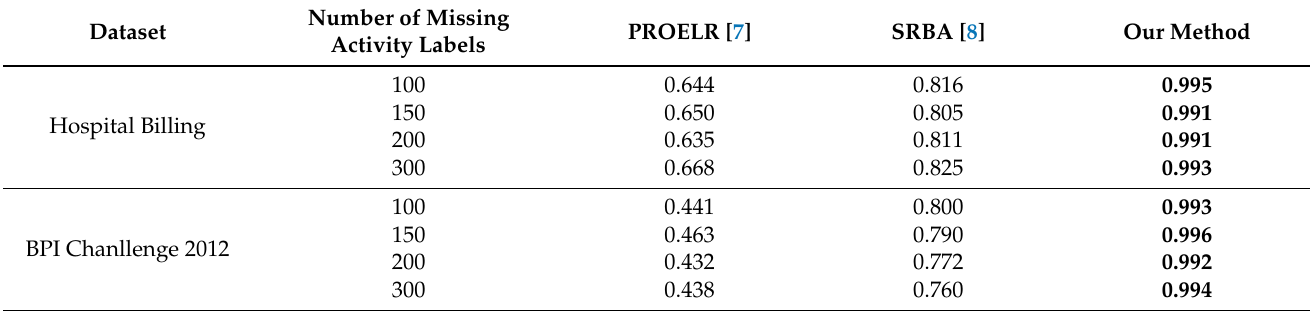
Table 6. Comparison of our method with PROELR [7] and SRBA